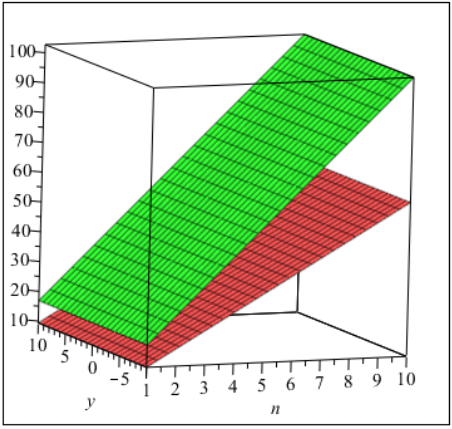
Figure 9. The graphical representation of the first and second hyper-Zagreb polynomial in a 2 D structure of face-centered cubic lattice FCC ( n ) . The colors blue and green represent HM 1 ( G , x ) and HM 2 ( G , x ) , respectively.